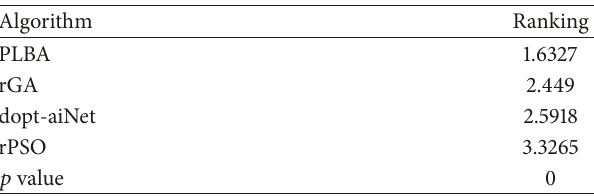
Table 19: Average rankings of PLBA and other comparable algo- rithms(Friedman)ondynamicbenchmarkproblems 𝐹 1 – 𝐹 6 interms of both solution quality and convergence speed.